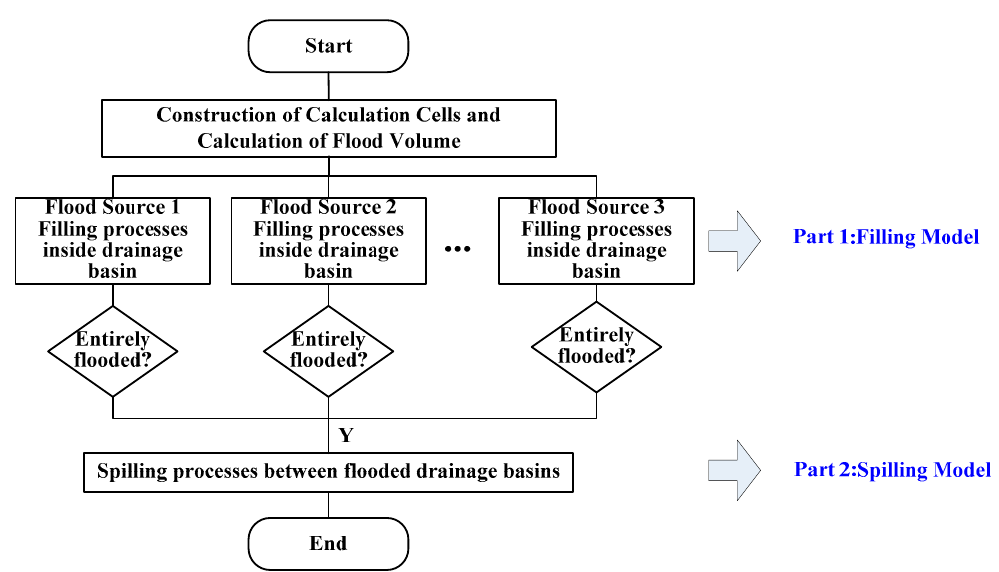
Figure 1. Model structure of new rapid simplified inundation model (NRSIM): (1) Filling model: for each flood source, the volume of inundation water is first distributed over the corresponding drainage basin by using the water spreading algorithm; and (2) Spilling model: water spilling between flooded drainage basins is computed by using an improved D8 algorithm.